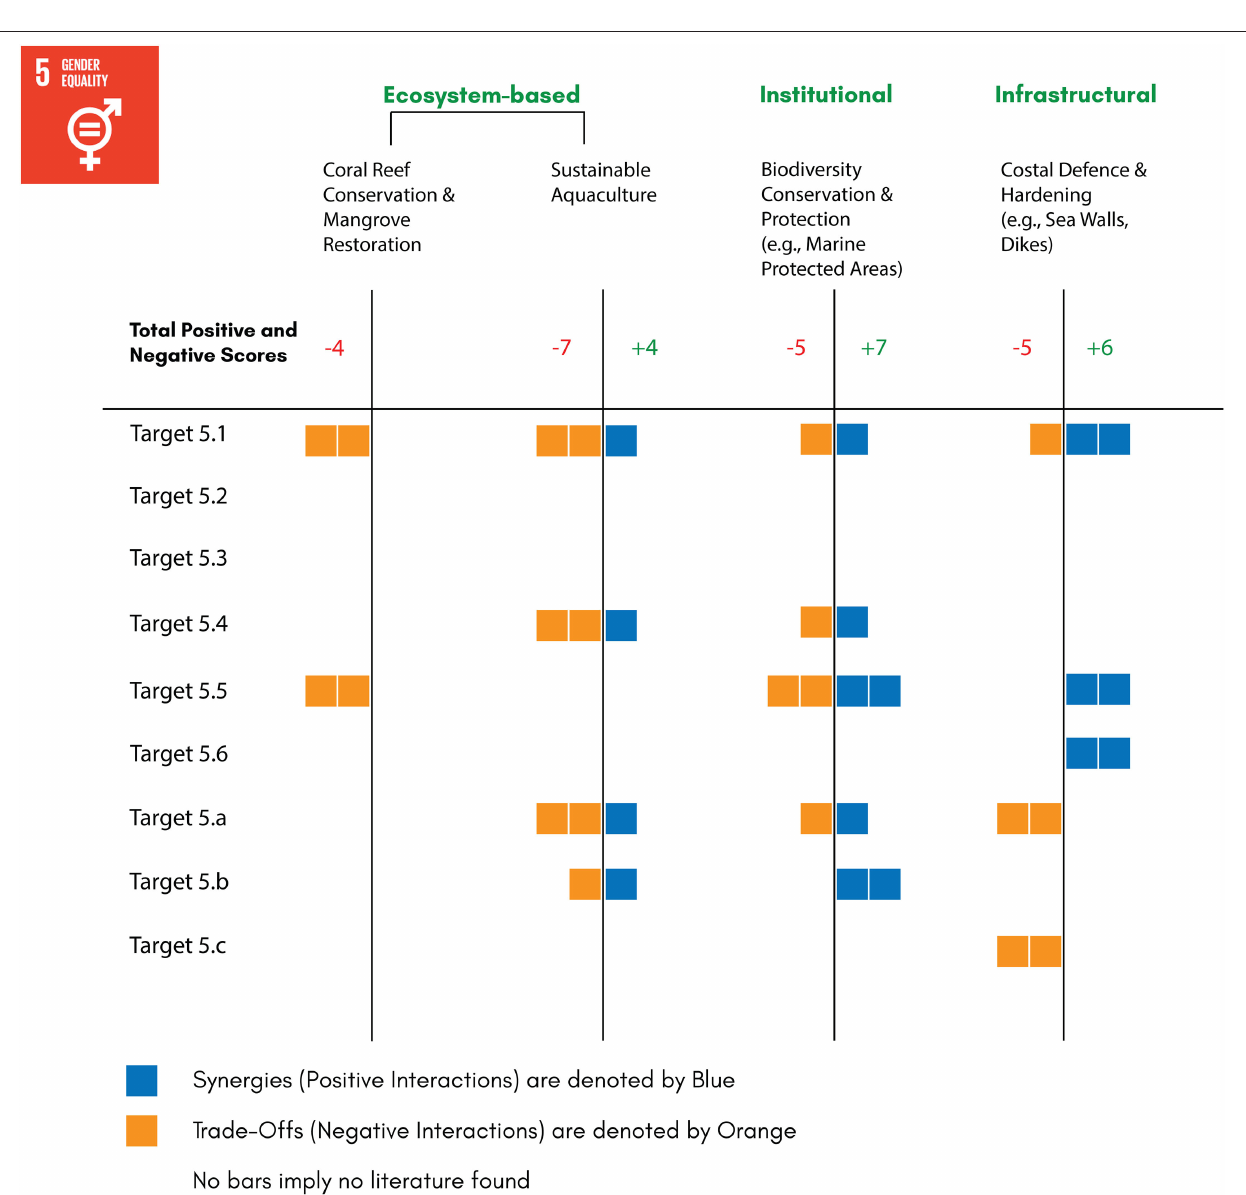
FIGURE 3 | Synergies and trade-offs between coastal climate adaptation and SDG 5—gender